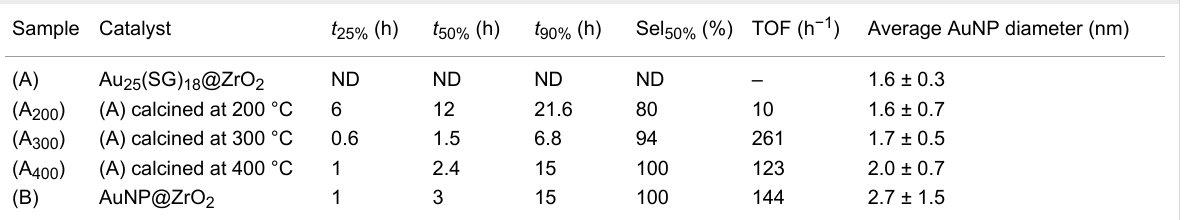
Table 1: Catalytic performance of Au 25 (SG) 18 @ZrO 2 based catalysts (2 µmol Au) in the oxidative dehydrogenation of benzyl alcohol in toluene at 80 °C (1 atm of air): 25%, 50% and 90% conversion times ( t ), benzaldehyde selectivity at half conversion (Sel 50%), turn over frequency (TOF) and gold particle size measured by TEM before the catalytic test. ND: Not determined. Sample Catalyst